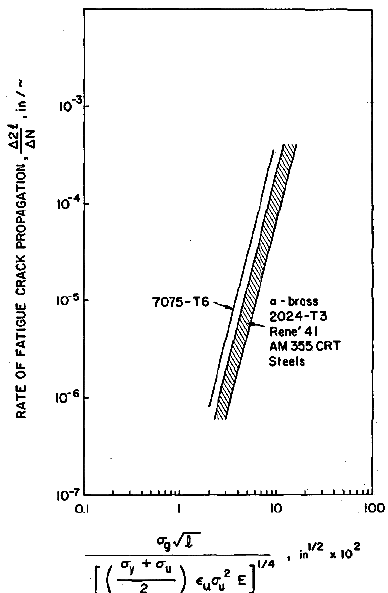
Figure 2. “Universal” curve of fatigue crack propagation rate for several materials [23].